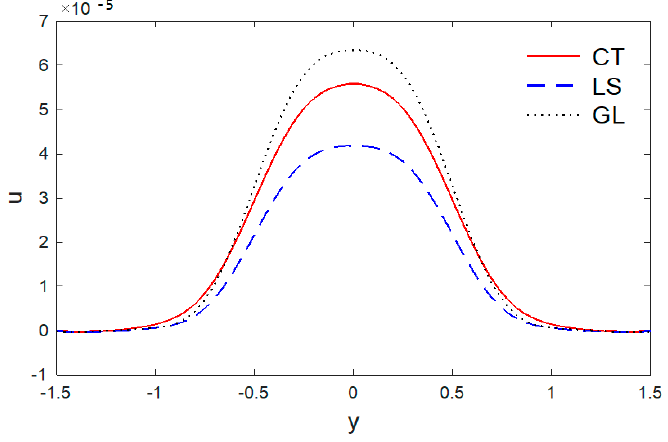
Figure 2. The horizontal displacement variations u via y , with x = 0.5 under the three models.